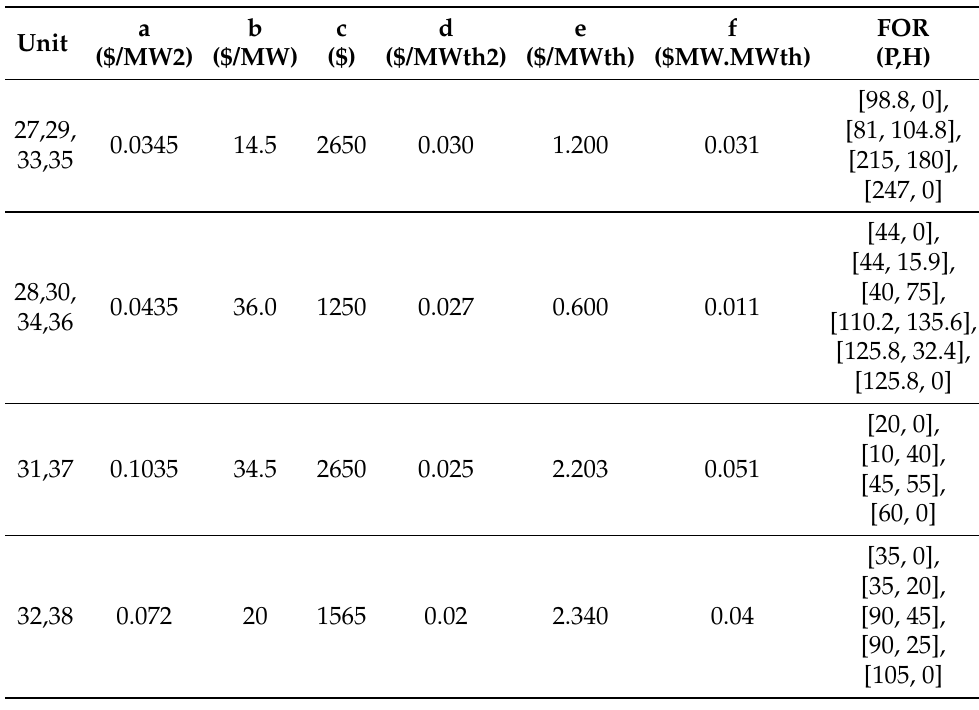
Table A17. Cogeneration unit data for Case Study 6.